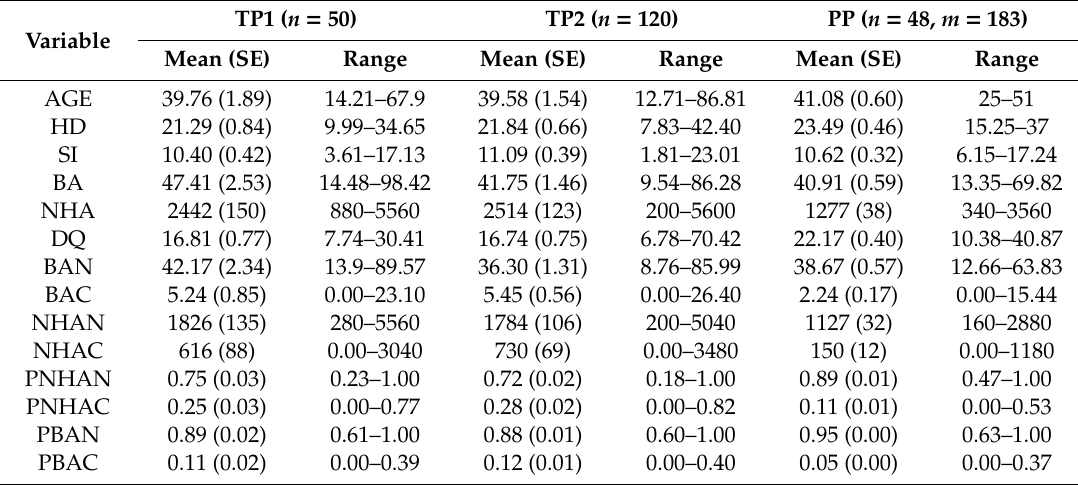
Table 1. Mean (standard error (SE)) and range of stand variables between plot series. Variable